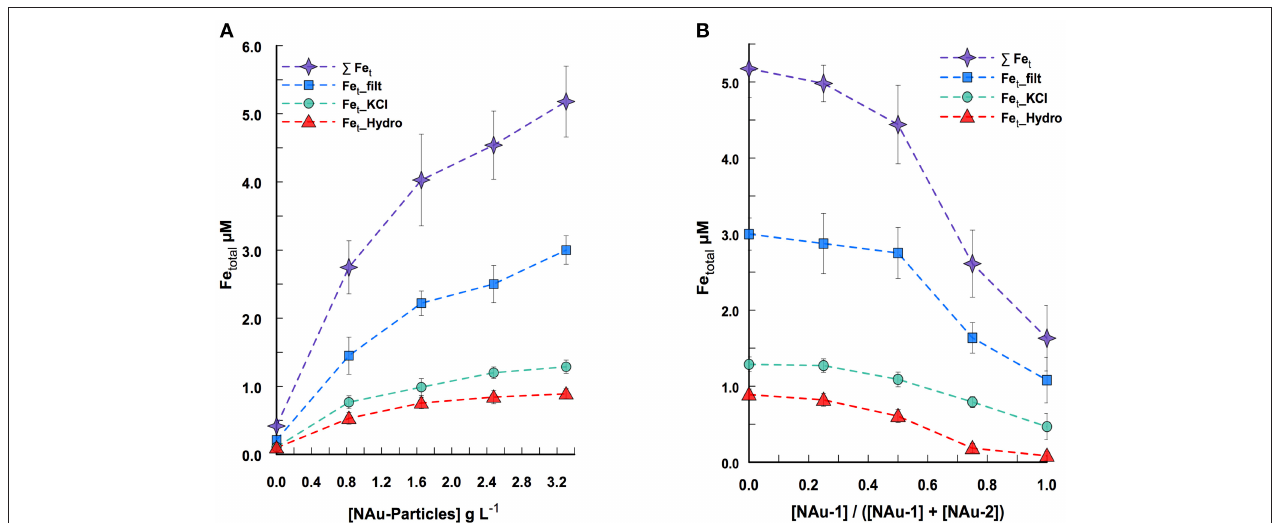
FIGURE 1 | P. aeruginosa -promoted Fe dissolution from silica gel-embedded nontronites in a system where NAu-1 to NAu-2 ratios are varied across a range of particle concentration, after 24 h of incubation. (A) Fe dissolution for a constant NAu-1 to NAu-2 ratio ([NAu-1]/([NAu-1] + [NAu-2]) = 0) while the particle concentration varied. (B) Fe dissolution for a constant particle concentration (3.3 g L − 1 ) with different NAu-1 to NAu-2 ratios. The symbols represent soluble Fe (squares), KCl extracted Fe (circles), hydroxylamine-KCl extracted Fe (triangles) and the sum of the three above Fe concentrations (stars). Error bars indicate